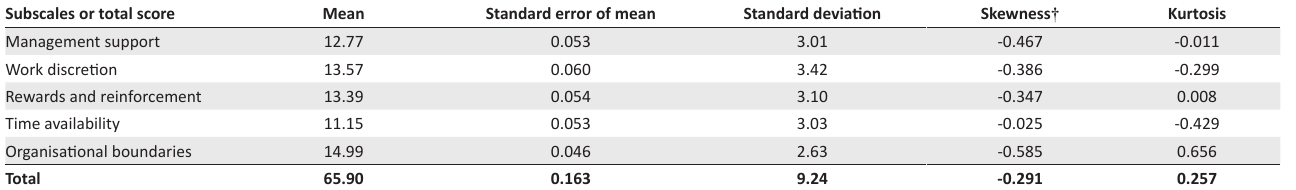
TABLE 2: Descriptive statistics for subscales and shortened Corporate Entrepreneurship Assessment Instrument total score. Subscales or total score